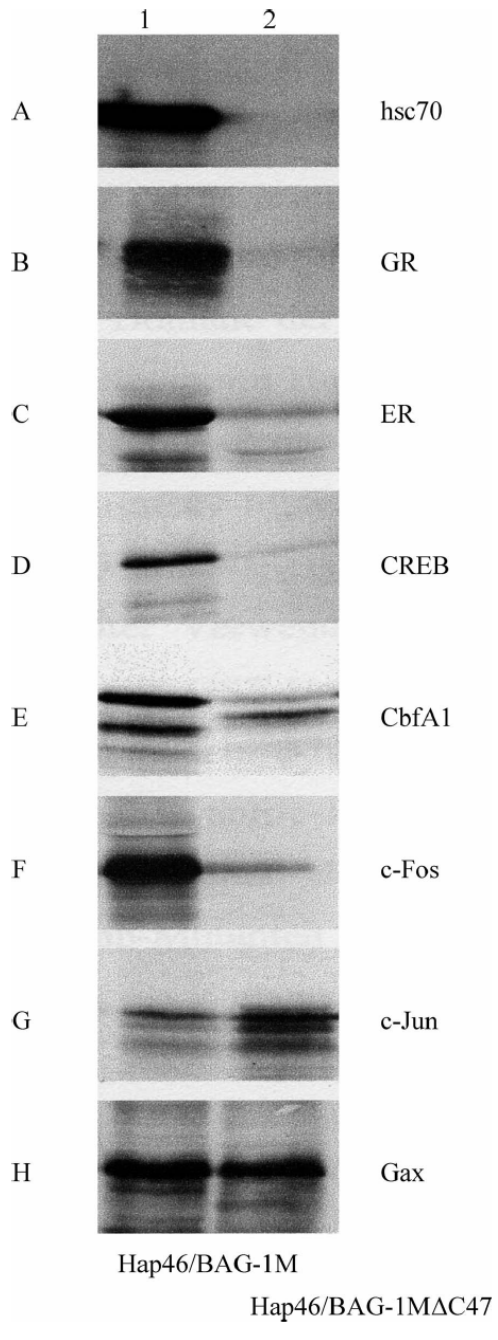
Figure 3. Formation of Hap46/BAG-1M complexes with several transcription factors. Transcription factors, as indicated, were synthesized as radiolabeled proteins by in vitro transcription/translation from recombinant constructs. They were then incubated in the presence of hsc70, contained in the reticulocyte lysate, with Sepharose matrices to which either Hap46/BAG-1M (lanes 1) or deletion variant Hap46/BAG-1M Δ C47 (lanes 2) had been attached. After extensive washing, retained proteins were eluted and analyzed by electrophoresis in SDS-containing polyacrylamide gels and radioautography. Glucocorticoid receptor (GR); Estrogen receptor (ER). From ref.